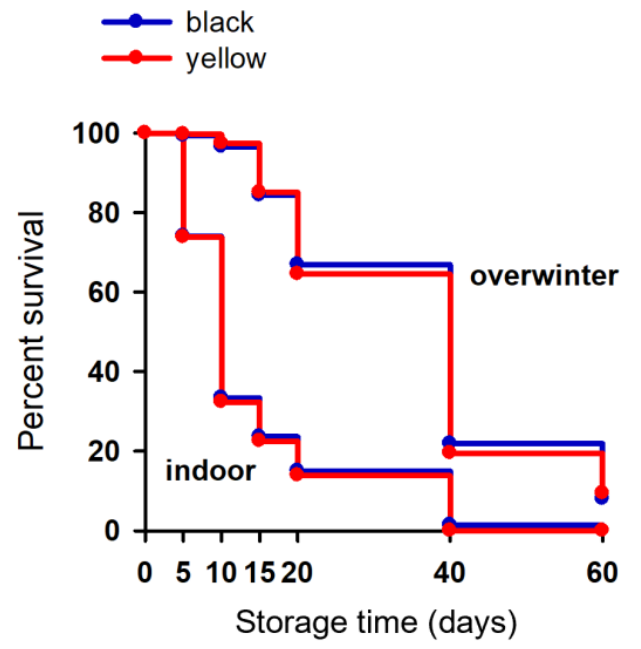
Figure 7. Representative survival curves of overwinter and experimental (indoor) black and yellow adults after low-temperature storage for 60 days; n = 180–235 adult beetles. Data are representative of three independent experiments.